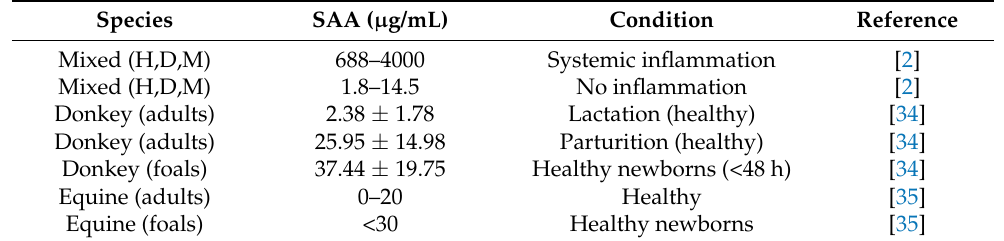
Table 2. SAA values reported in horses (H), donkeys (D), and mules (M) with different conditions.